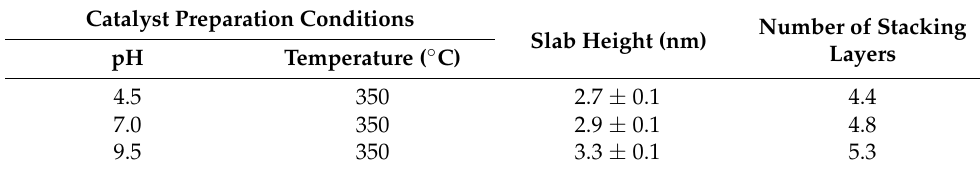
Figure 2. XRD patterns of ( a ) commercial MoS 2 and MoS 2 samples prepared at ( b ) pH 4.5; ( c ) pH 7.0; and ( d ) pH 9.5. Table 1. Crystalline characteristics of MoS 2